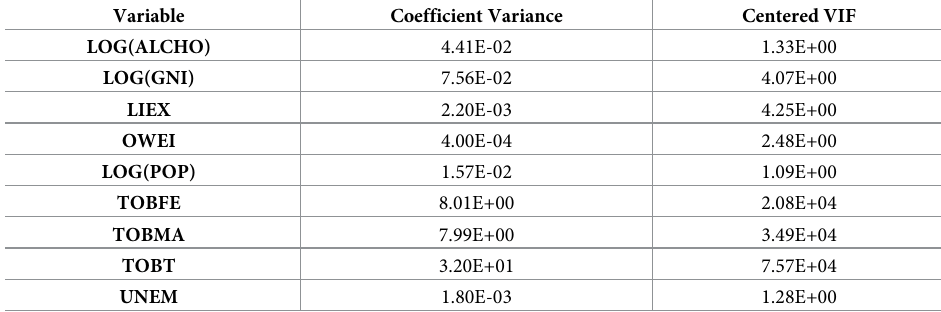
Table 5. Variance inflation factors calculated for nine model variables included in the unrestricted model.